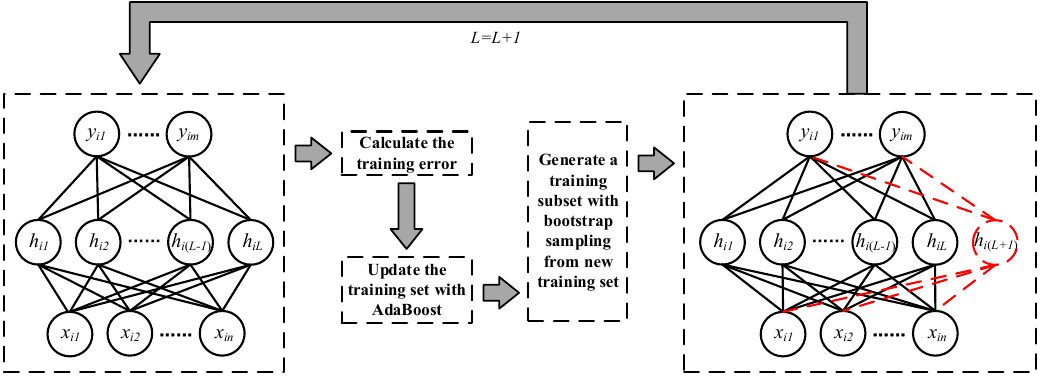
Figure 4. The flow of AdaBoost-Bootstrap-SCN method. Algorithm 3: The pseudo code of AdaBoost-Bootstrap-SCN method.